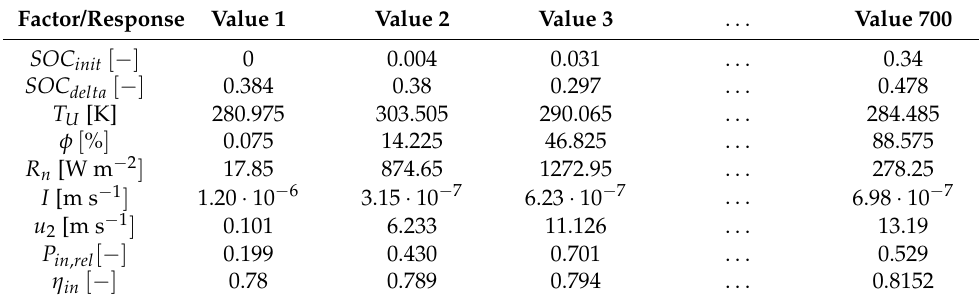
Table 4. Design of